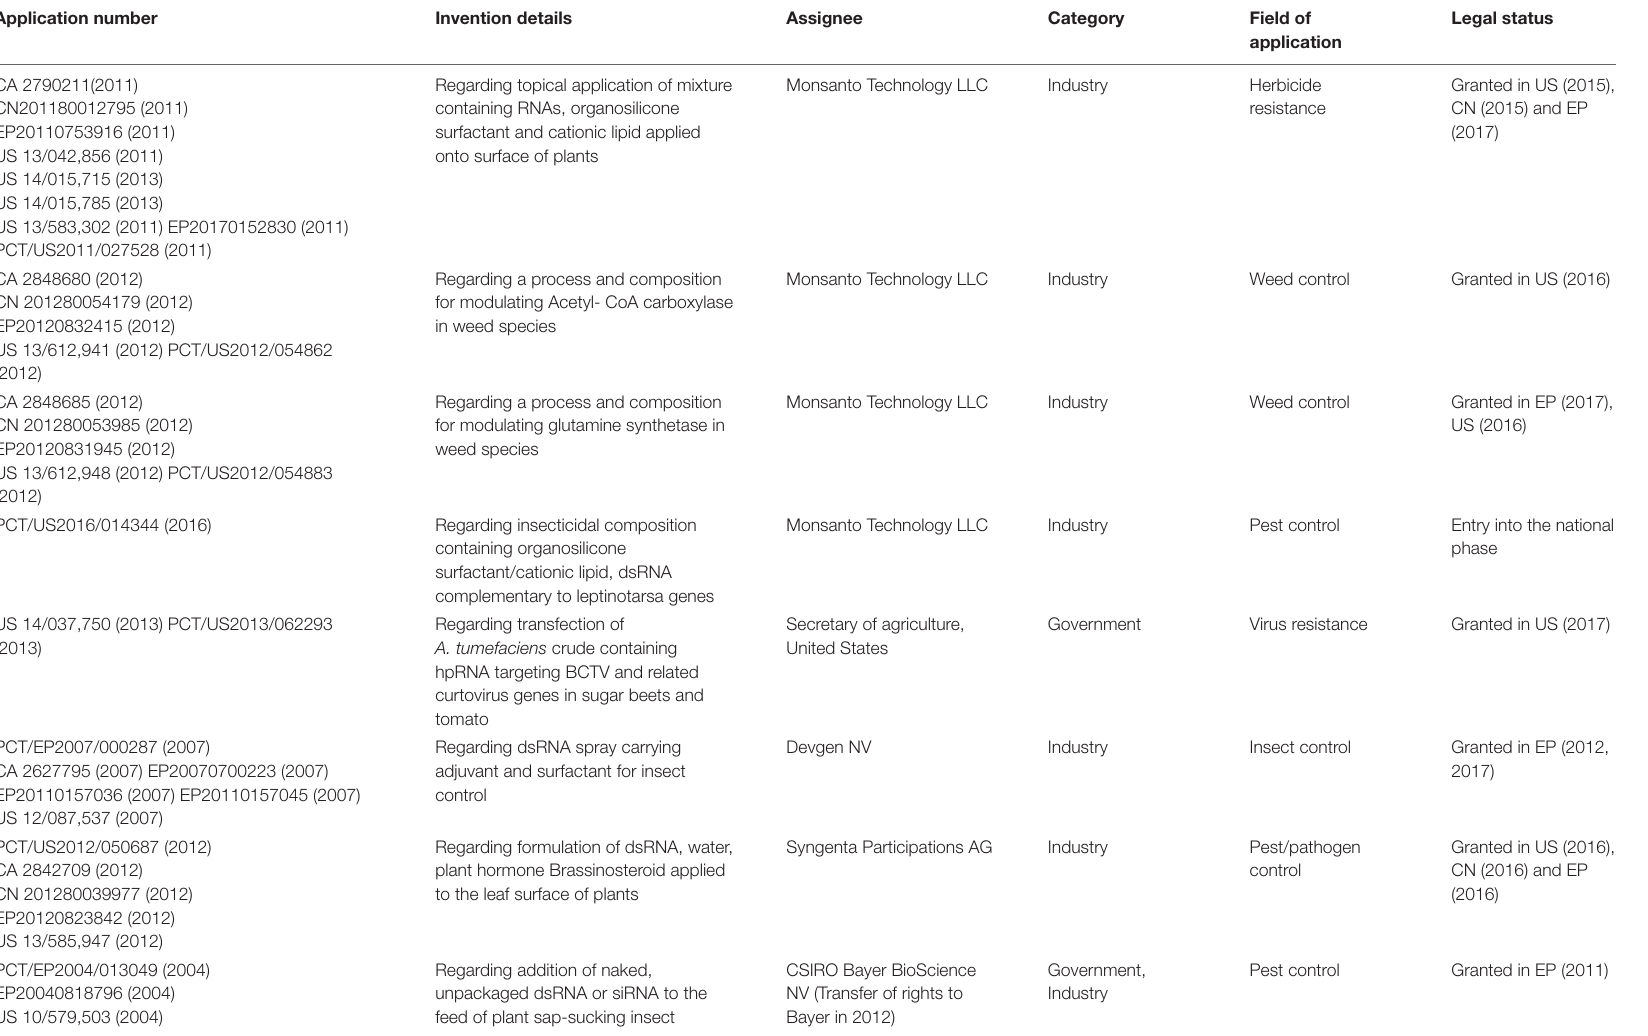
TABLE 6 | List of patent applications related to RNAi-inducing exogenous application of dsRNAs. Application